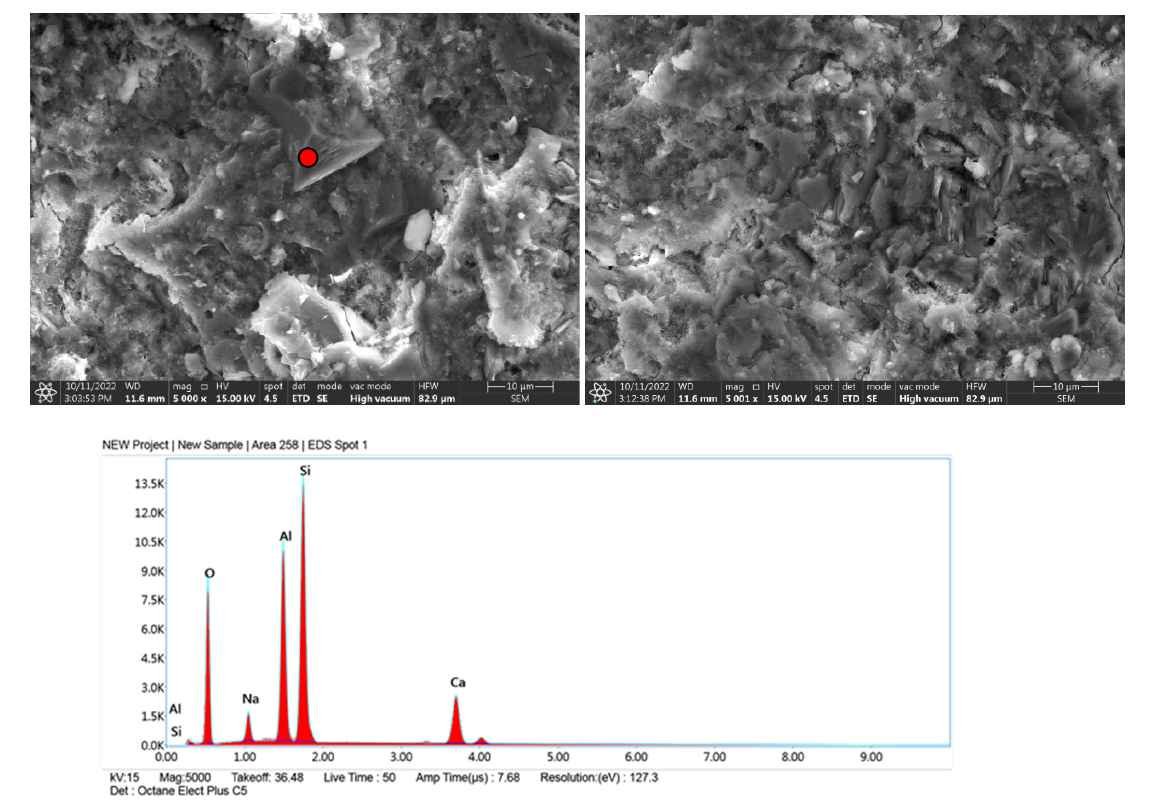
Figure 9. Microphotographs with EDS analysis of sample with granite powder after 3 h grinding.